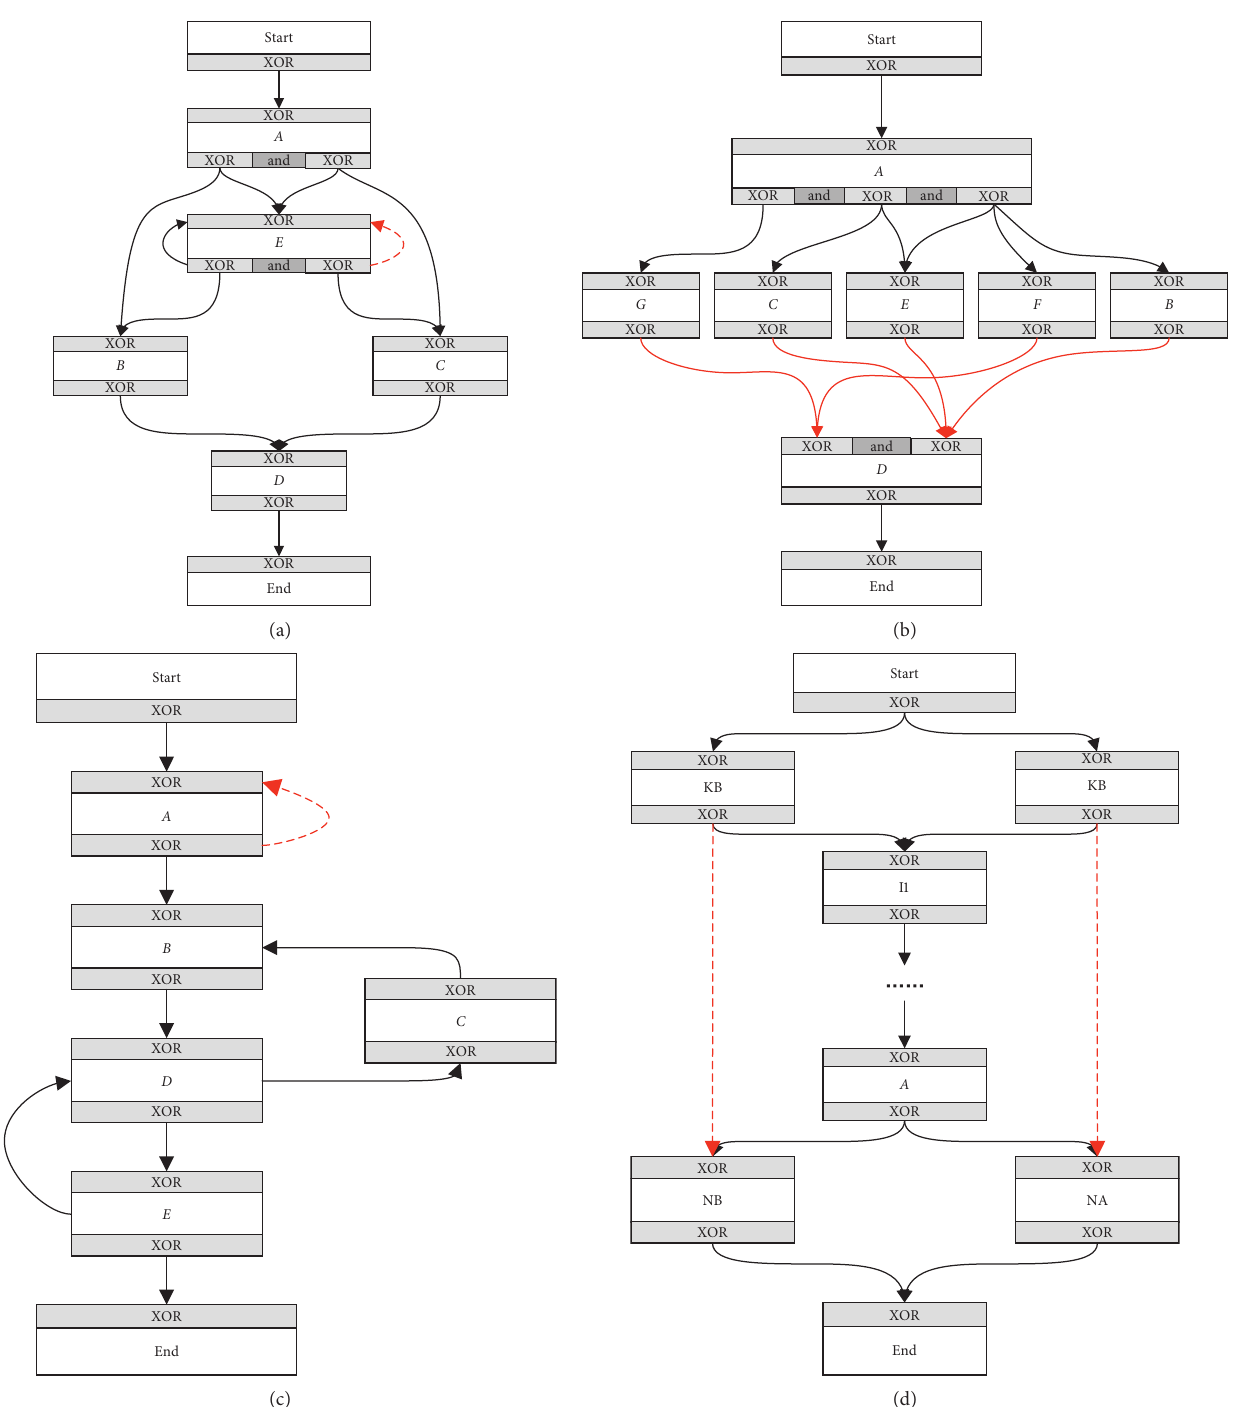
Figure 6: Mining results of four event logs: (a) a5; (b) a7; (c) h6p18; (d)